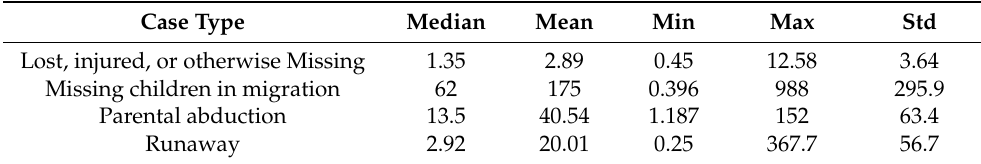
Table 1. Summary statistics (in days) for the resolution of cases per case type from the dataset of missing children’s past